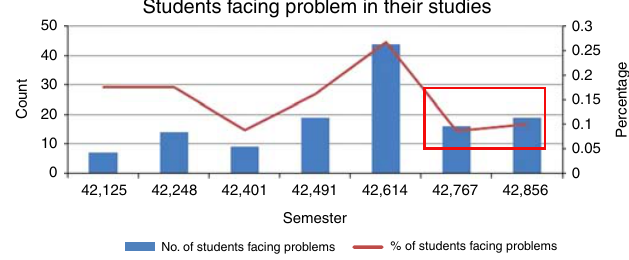
Figure 2. Percentage of